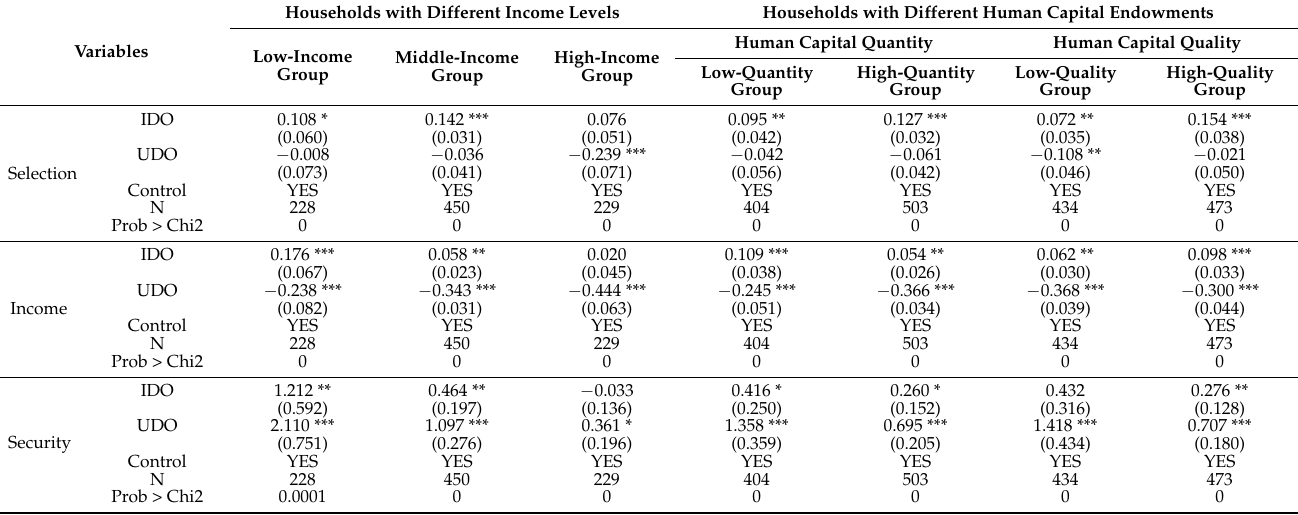
Table 4. Heterogeneity effect of the impact of heterogeneous land development opportunities on rural household